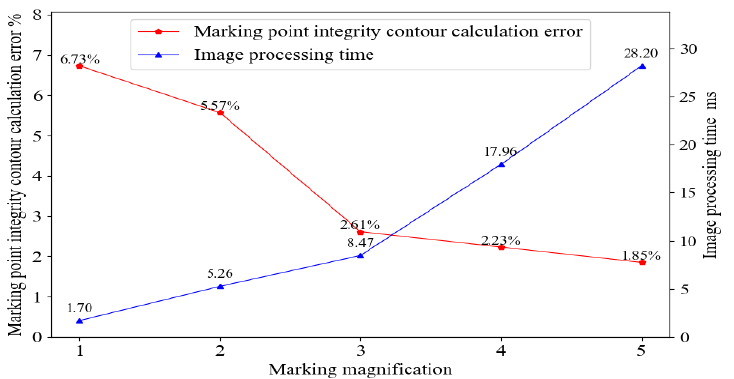
Figure 5. The relationship between the image magnification of the marking point and the calculation error of the integrity contour and the image processing time.